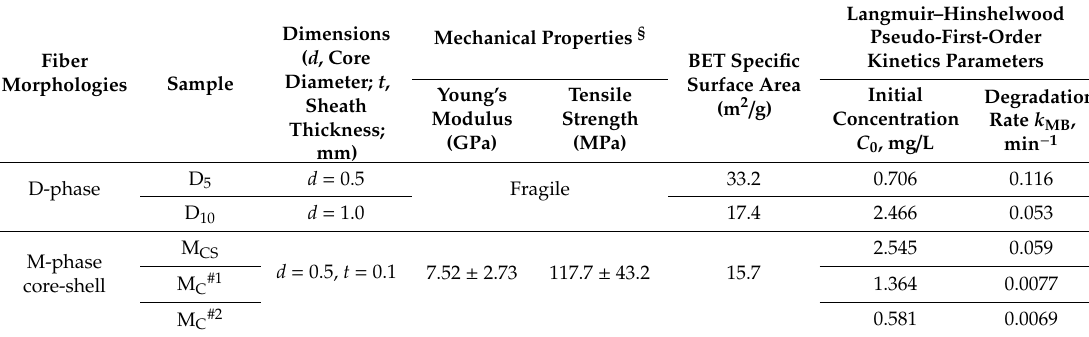
Figure S2. #1,2 are core-shell fibers used for the second-cycle measurement of